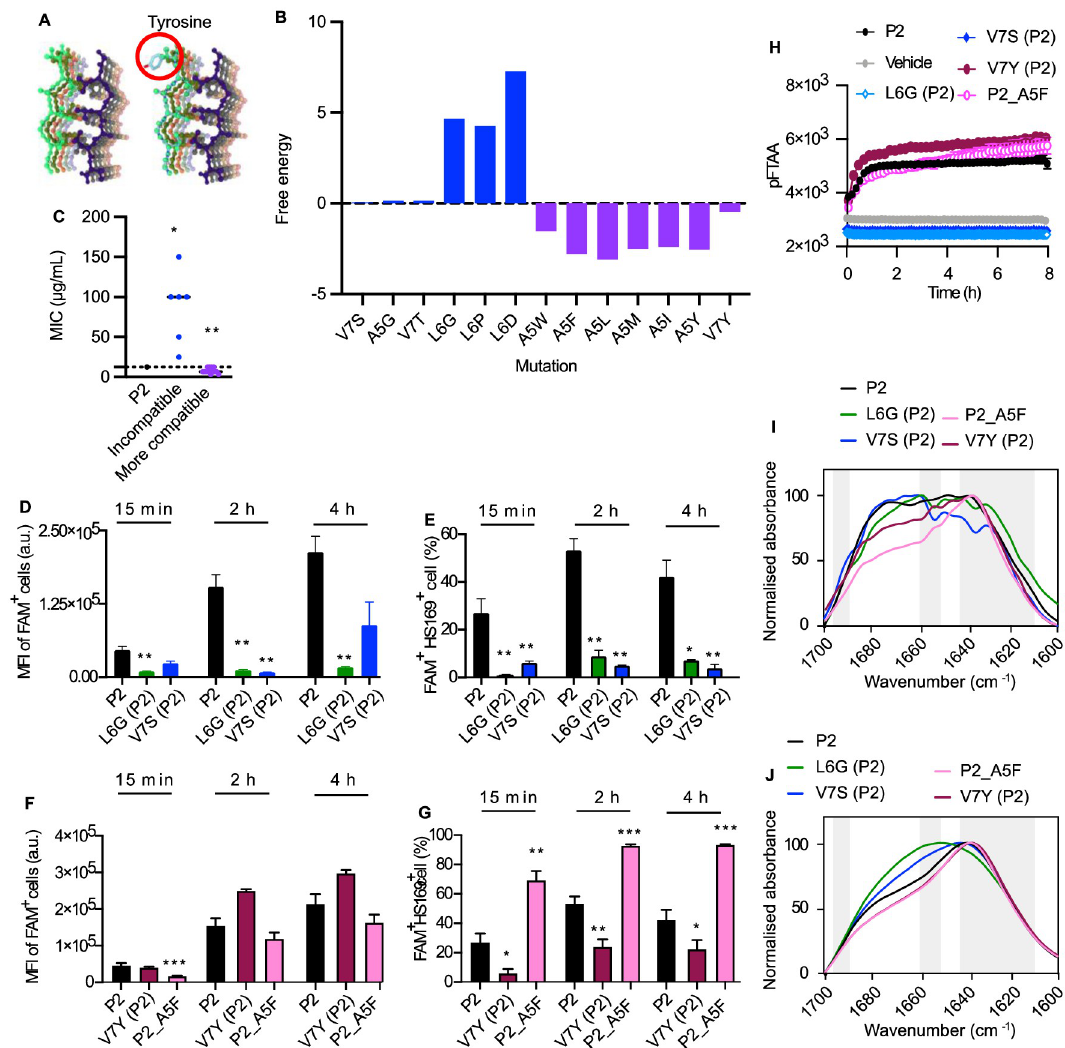
Fig 3. Optimizing the aggregate core structure enhances Pept-in antimicrobial potency. A: The most likely structure predicted by Cordax for the amyloid core formed between P2 ( left ) and the APR of target proteins. The impact of introducing a mutant in the APR (e.g., V7Y) ( right ) can then be evaluated using the FoldX force field. B: Free energy of the APR structure calculated by FoldX after introducing a single mutation in the APR region. Blue bars represent mutations that are incompatible with the cross-beta core structure, while purple bars represent the ones that are more compatible with the cross-beta core structure. C : MIC of P2 variants generated by modifying the aggregate core structure against E . coli BL21. This figure is associated with data from S6 Table. Each dot represents the MIC of one Pept-in design. D-H: P2 variants which are incompatible with the cross-beta core structure: L6G (P2); V7S (P2); P2 variants which are more compatible with the cross-beta core structure more compatible: V7Y (P2), P2_A5F. D-G: Flow cytometry analysis of E . coli BL21 treated with FAM-labelled Pept-ins for different time points at FAM-P2-MIC from three independent experiments. Samples were acquired using Gallios Flow Cytometry. MFI of FAM + cells ( D ), and the percentage + of FAM and HS169 + cells ( E ) when treated with P2 and its derivatives with decreased antimicrobial potency. MFI of FAM + cells ( F ), and the percentage + of FAM and HS169 + cells ( G ) when treated with P2 and its derivatives with increased antimicrobial potency. Error bars represent SEM. H: Time dependence of pFTAA (0.5 μ M) fluorescence intensity of P2 derivatives (50 μ M) in the presence of PolyP (0.5 mM). (n = at least 6). I-J: FTIR spectrum of P2 variants with altered compatibility to the aggregate core structure in PBS (6% DMSO), without ( I ) or with ( J ) the presence of PolyP. The absorbance is normalised between all samples and the spectrum is scaled to the amide I region between 1600–1700 cm − 1 . Peaks within the left (1689–1696 cm − 1 ) and right (1610–1642 cm − 1 ) grey bar are assigned to β -sheet, while peaks within the grey bar in the middle (1651–1659 cm − 1 ) is assigned to α -helix. The FTIR spectrums are representative of three independent experiments. For C , one-sample Wilcoxon signed-rank test was used to compare the MIC median of each Pept-in group to P2 MIC (12.5 μ g/mL). For D-G , a two-tailed Student t-test was performed for calculating statistical significance between the mean of P2 variant and P2 (n = at least 6). Asterisks indicating the level of the p value centred over the error bar mean: * p < 0.05, ** p < 0.01, *** p < 0.001, and **** p <